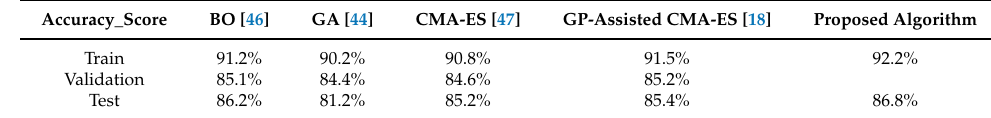
Table 1. Simulated results of all experimental algorithms with 500 spiking neurons on MINIST.